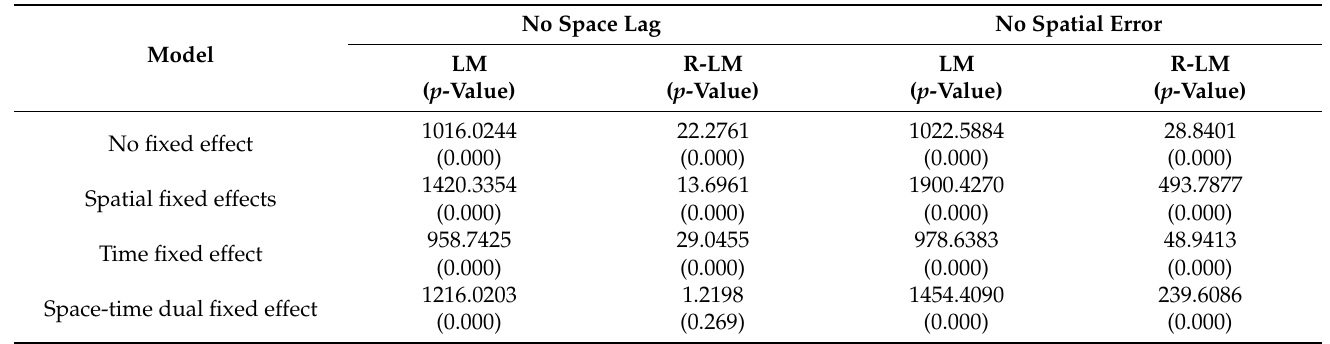
Table 3. LM test results.